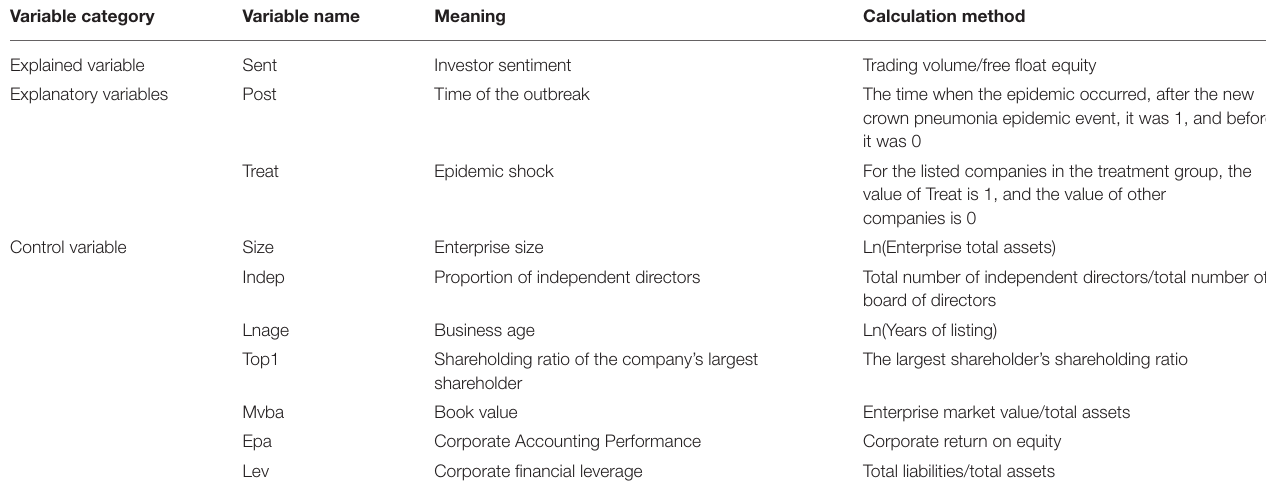
TABLE 2 | The description and definitions of main variables.